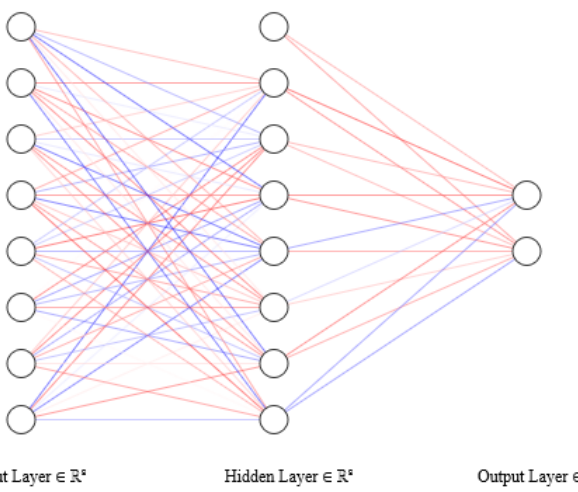
Figure 1. Multi-layer perceptron ANN with one hidden layer (the figure is generated using an online tool